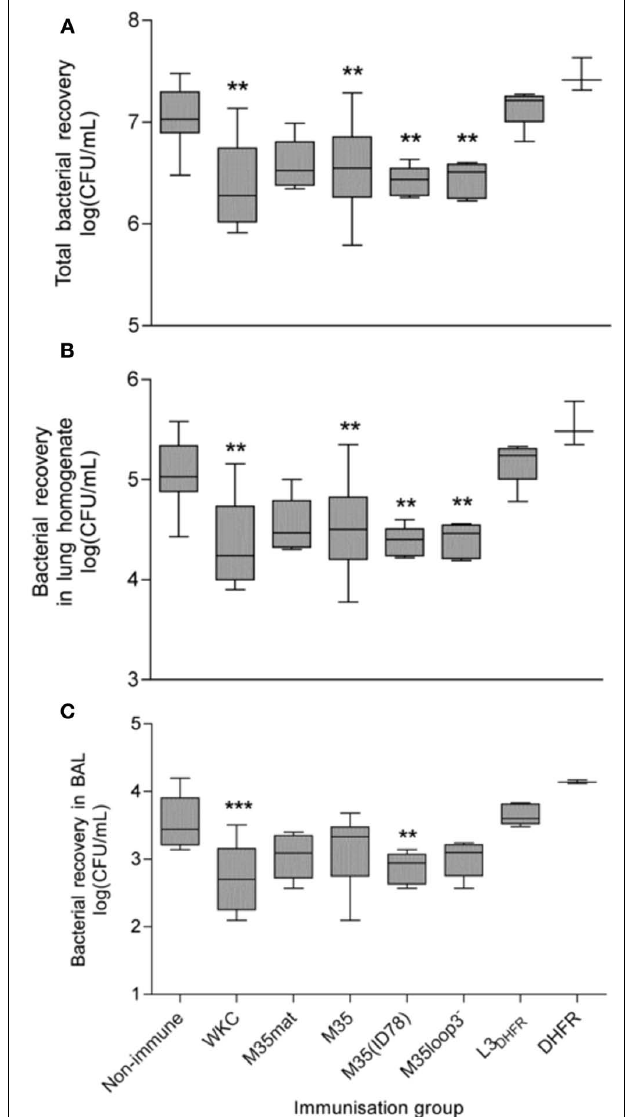
FIGURE 5 | Bacterial recovery after 4h challenge with live M. catarrhalis . (A) Total recovery, (B) recovery from lung homogenate, and (C) recovery from BAL fluid. Boxes represent the 25th–75th percentile, the line through the box indicates the median and the whiskers extend between the highest and lowest values. Asterisks indicate statistical significance compared to the non-immunized control group: * p < 0.05, ** p < 0.01, *** p <